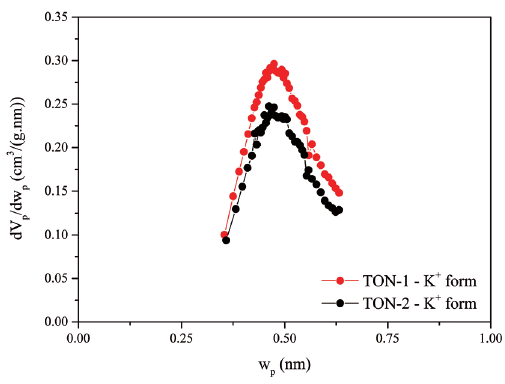
Figure 8: Micropore size distribution of TON-1 and TON-2 in K + form.